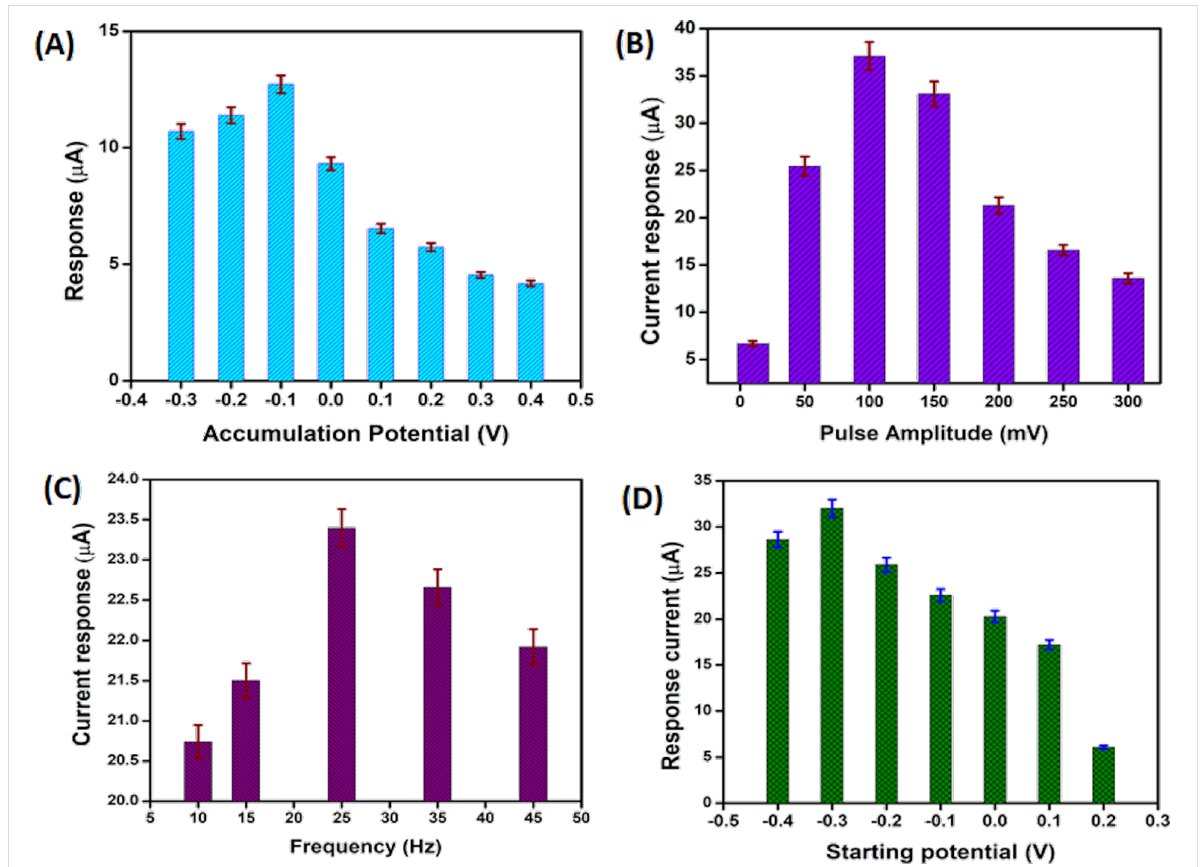
Figure 8: Relationship of stripping peak current in SWV measurements of 10 μ M PT as a function of accumulation potential (A), starting potential of scan (B), frequency (C), and pulse amplitude (D). The optimized parameters for PT detection in SWV are: pulse amplitude: 100 mV, starting potential: 0.3 V, frequency: 25 Hz, accumulation potential: − 0.1 V, and accumulation time: 240 s.